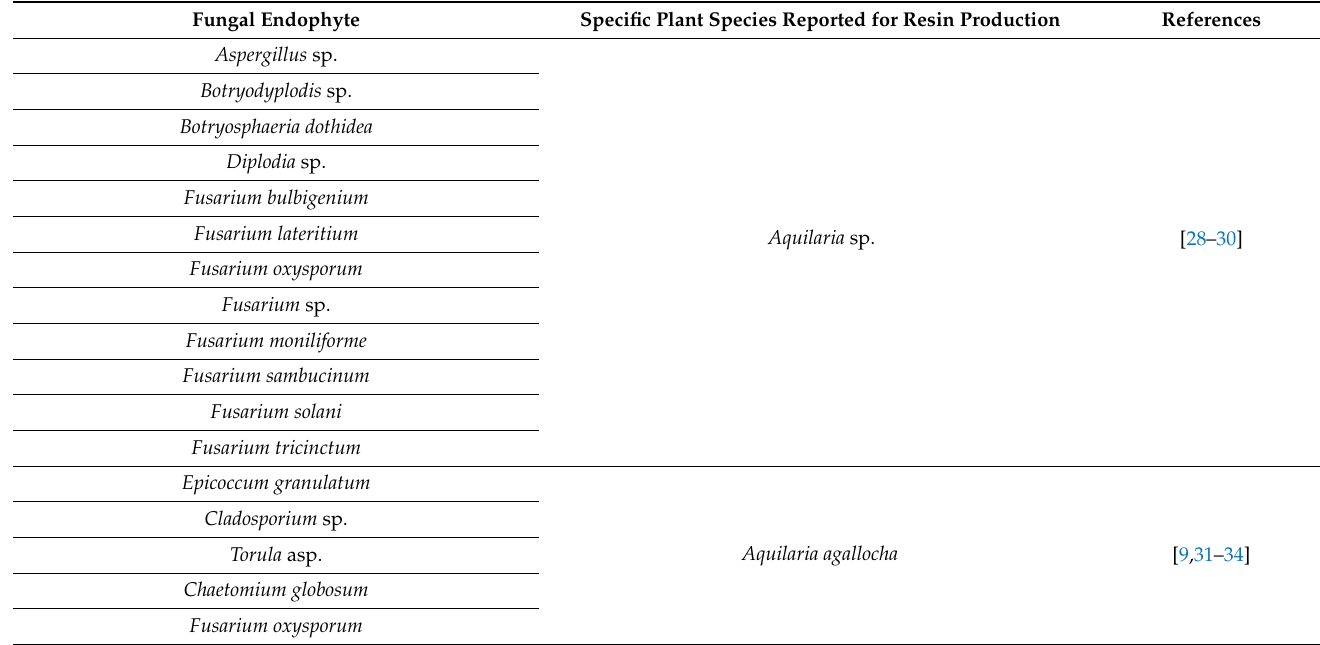
Table 2. Resin-inducing endophytic fungal species isolated from the Aquilaria and Gyrinops species. Fungal Endophyte Specific Plant Species Reported for Resin